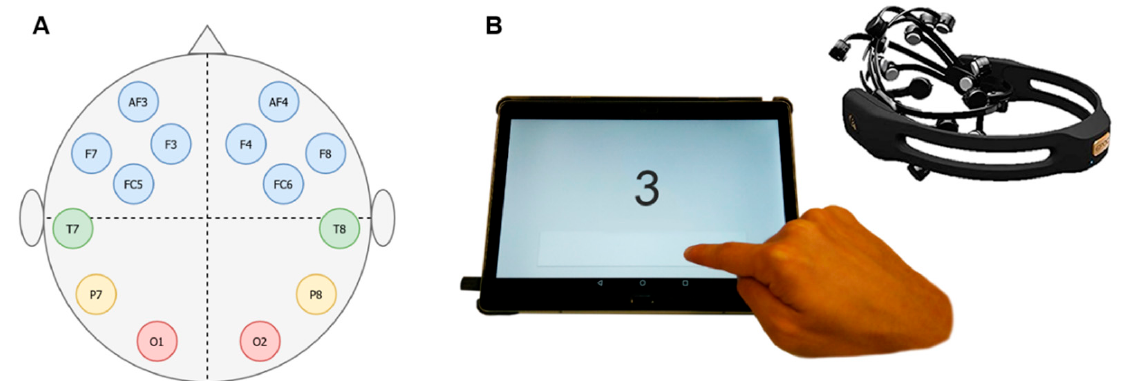
Figure 2. ( A ) Electrode placement. The figure depicts electrodes that are covered by the Emotiv Epoc mobile EEG device. Frontal electrodes are depicted in blue ( n = 8), temporal electrodes in green ( n = 2), parietal electrodes in yellow ( n = 2) and occipital electrodes in red ( n = 2). ( B ) Mobile setup. Display of the mobile EEG device and the tablet that was used for stimulus presentation. The figure illustrates an example of the N-back task. Participants were instructed to press the ‘button’ (visible on the lower part of the tablet screen) upon detection of a target stimulus. The rectangular button covered an area of 172 mm × 20 mm.